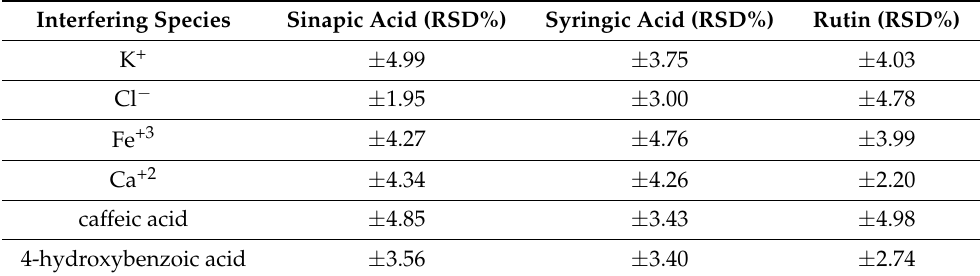
Table 5. Effect of various interferences on the determination of sinapic, syringic, and rutin.